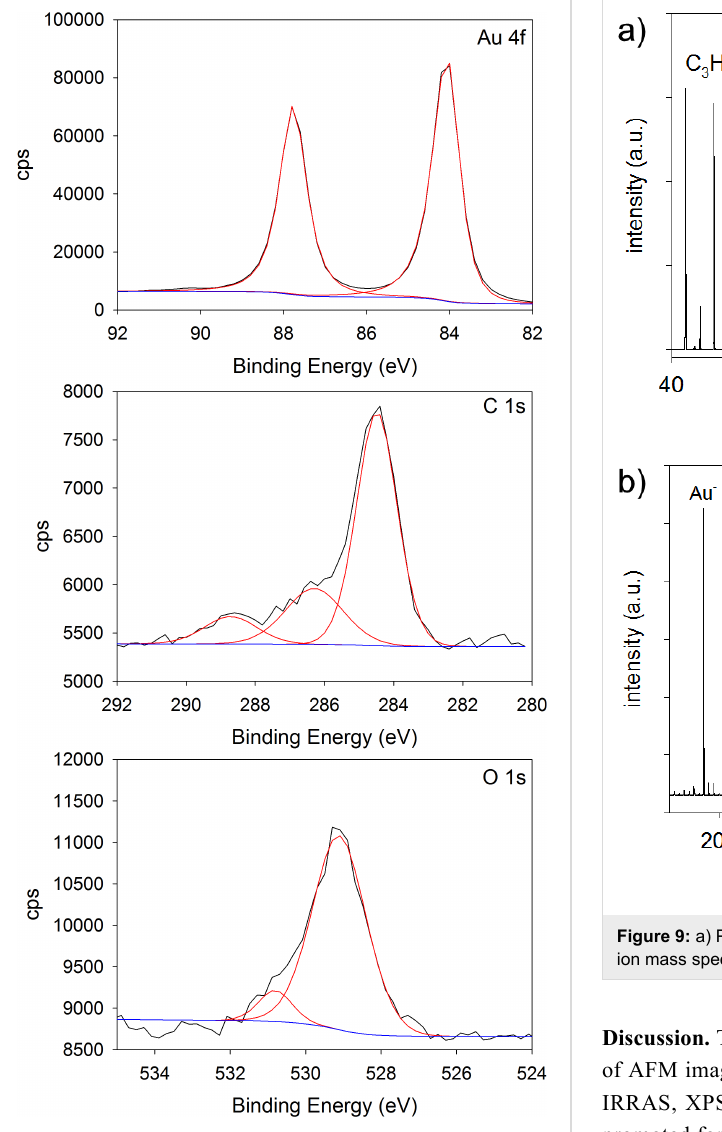
Figure 8: Au 4f, C 1s and O 1s photoelectron spectra of the deposited Au–Me layer.